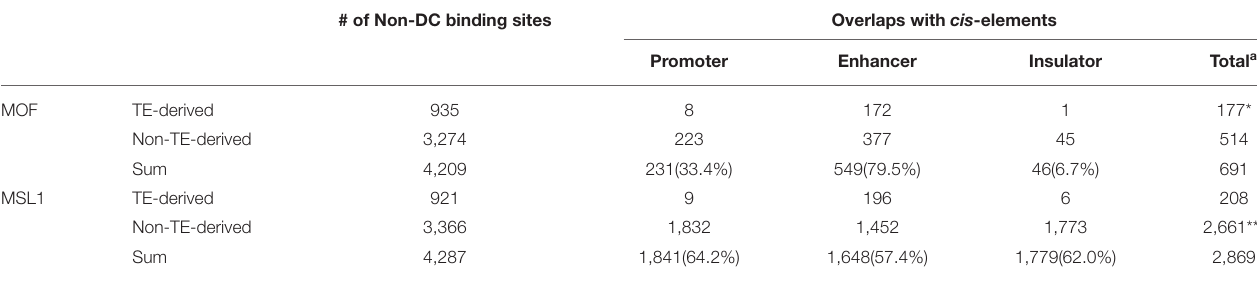
TABLE 2 | Overlap of non-DC MOF/MSL1 binding sites and known cis -regulatory elements in D. melanogaster . # of Non-DC binding